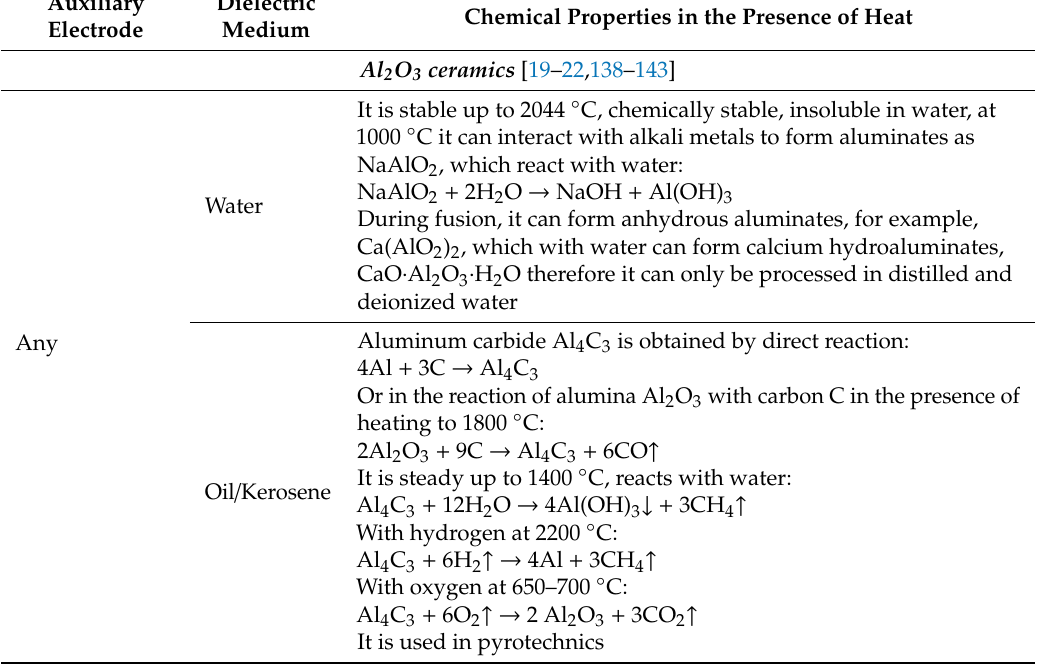
Table 2. The analytical chemical composition of erosion products and the subsurface layer of the processing surfaces during electrical erosion of some ceramics using a brass or copper electrode